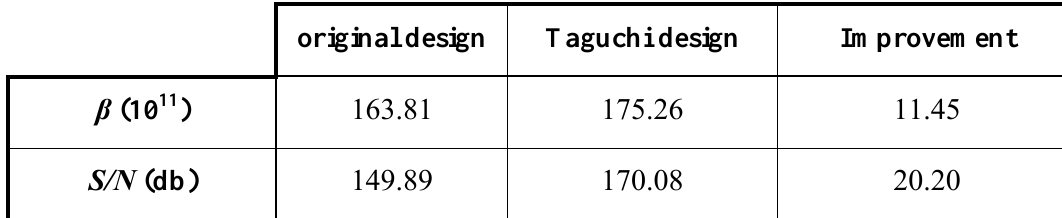
Table 6. The comparisons of S/N ratio between original design and Taguchi design.